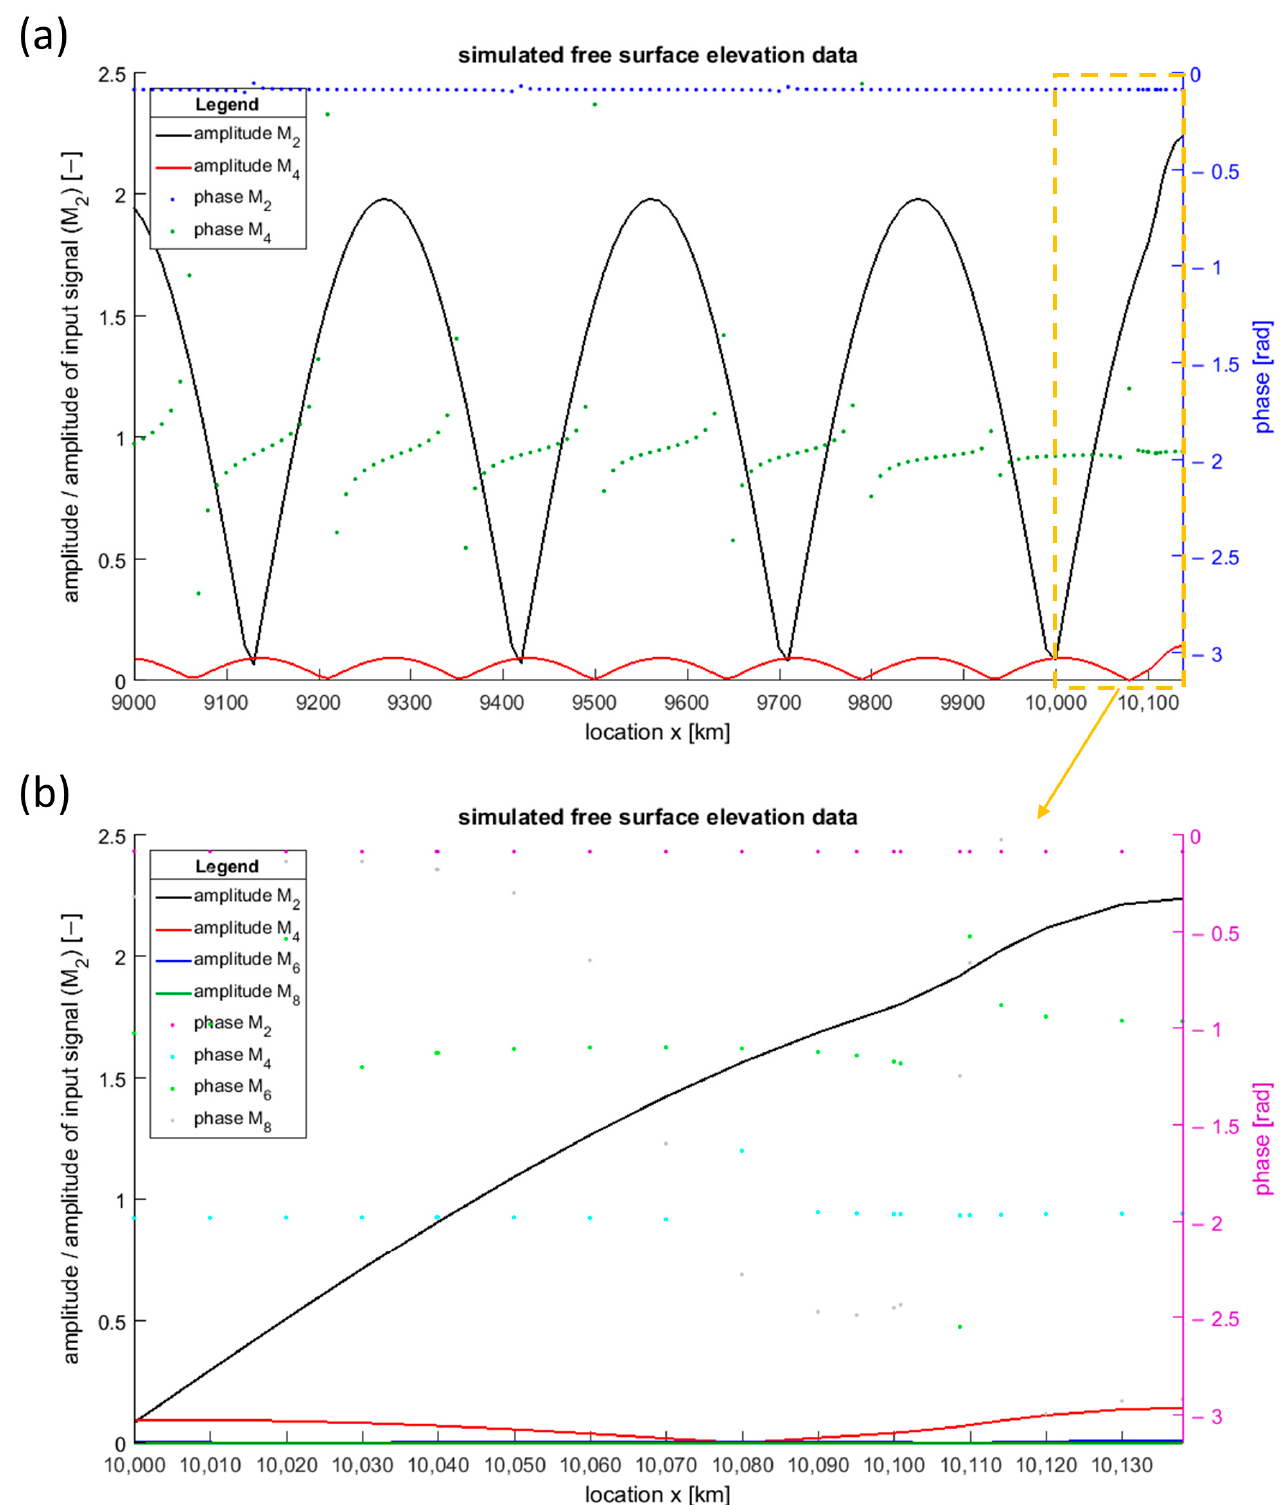
Figure 6. Visualization of the harmonic analysis results of the simulations data along the length sections from a model with a bathymetric change (at x = 10,100 km), constant model widths and a total reflector (x = 10,138 km): ( a ) the harmonic analysis results of the simulation data from x = 9000 km to 10,138 km for the M 2 and M 4 constituents; ( b ) the harmonic analysis results of the simulation data from x = 10,000 km to 10,139 km with additional representation of M 6 and M 8 con- stituents.